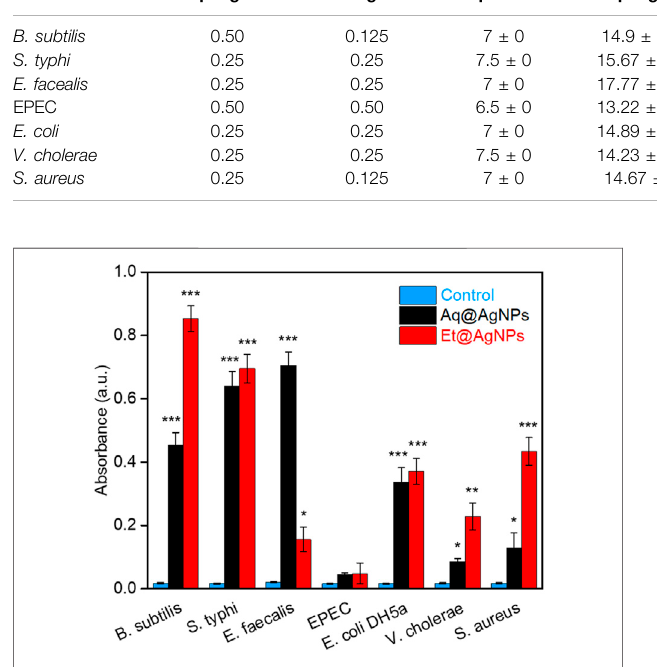
FIGURE 4 | Absorbance of MDA-TBA adduct at 532 nm ( n = 3). The absorbanceofMDA-TBAadductofbAgNPs-treatedbacteriawassigni fi cantly higher than that of the untreated bacteria (i.e., control). Here, p p < 0.05 vs. control, pp p < 0.01 vs. control, and ppp p < 0.001 vs.